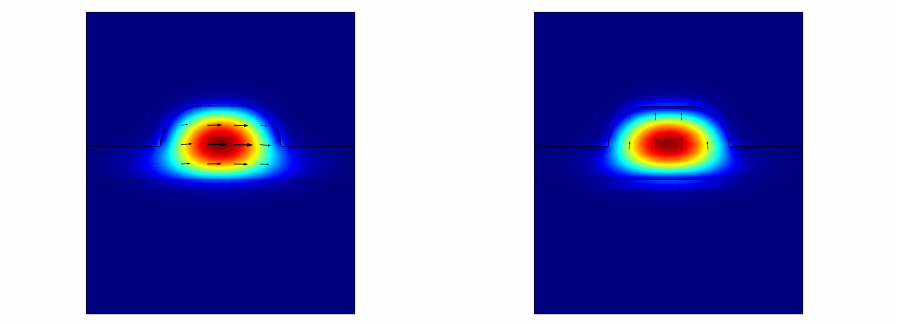
Figure 4. TE and TM modes profiles in a straight